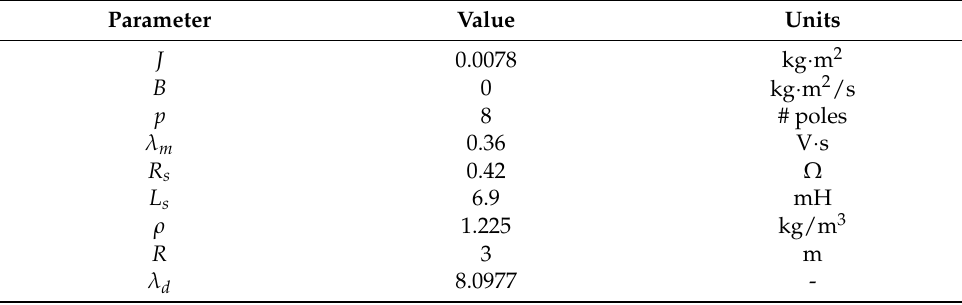
Table 1. System parameters for simulation platform.